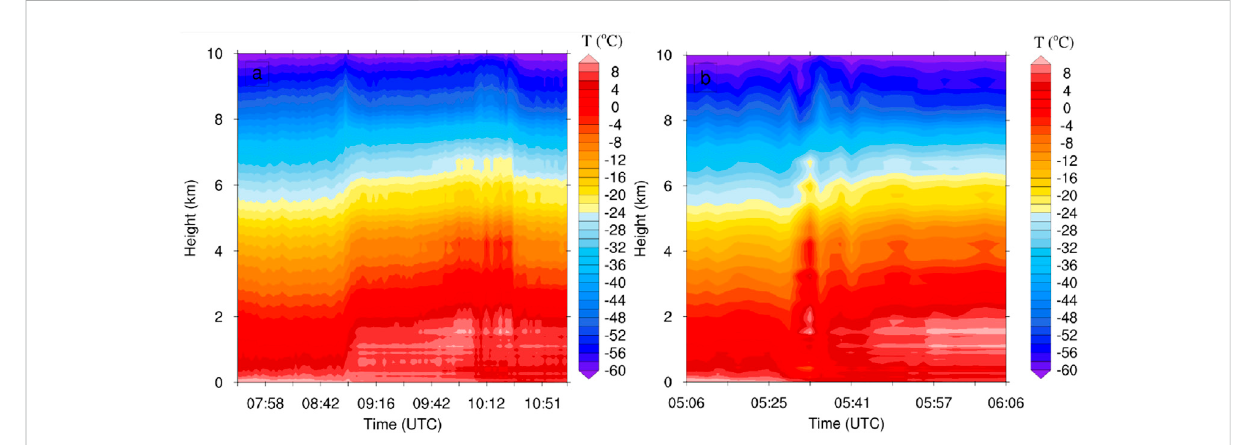
FIGURE 5 Time series of temperature distribution in (A) PV thunderstorm and (B) TC